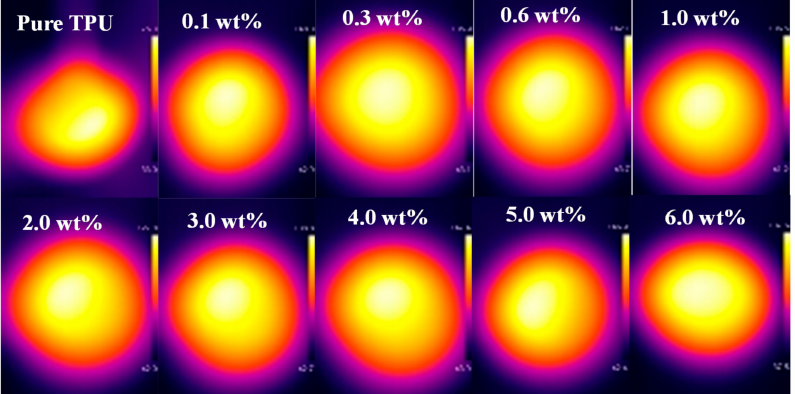
Figure 9. Infrared images of the pure TPU and G-TPU films with different mass contents of graphene